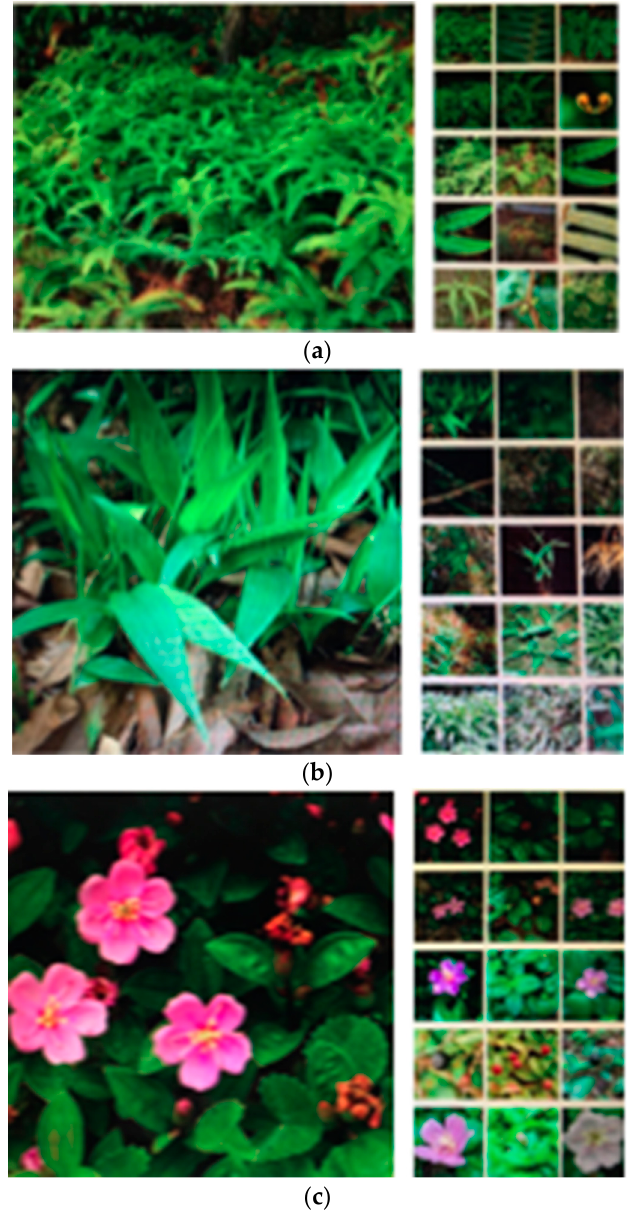
Figure A1. The morphological characteristics of the three species of understory plants in our study. ( a ) Dicranopteris dichotoma [54] ( b ) Lophatherum gracile [55] ( c ) Melastoma dodecandrum